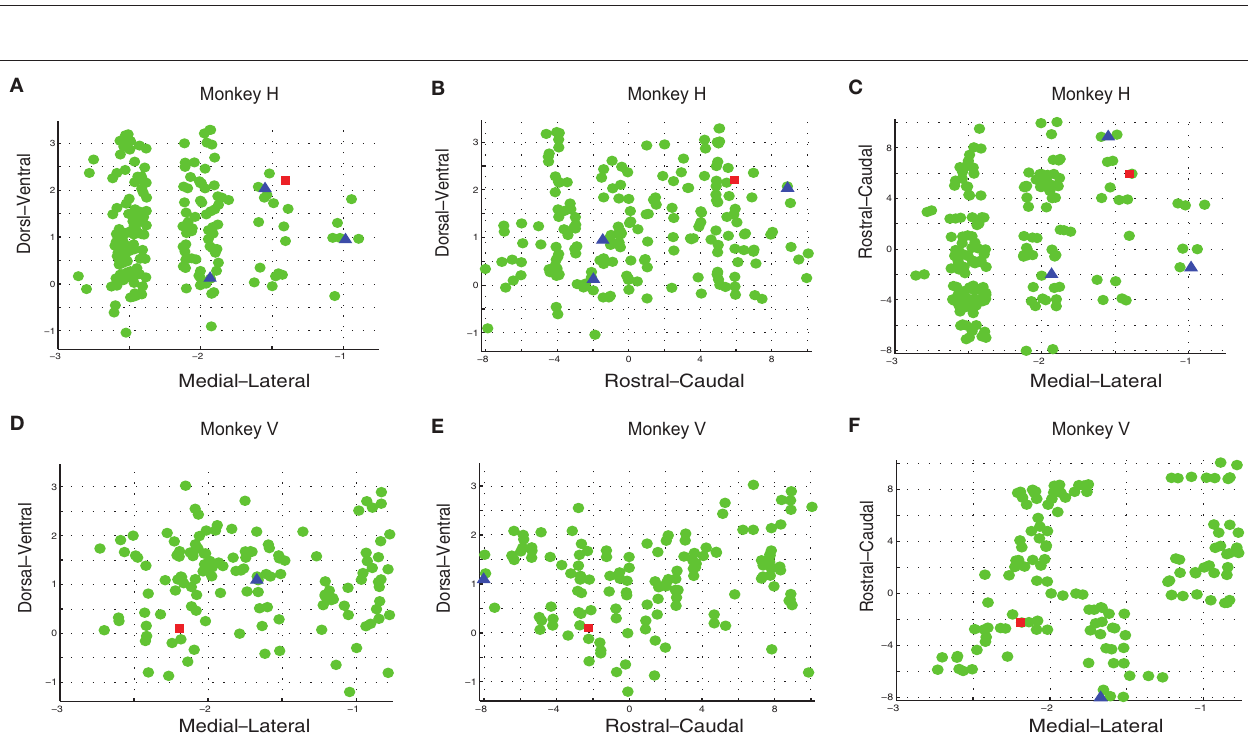
FigUre A3 | Untransformed version for the AVPSD method in Monkey V. See Figure 4 for further explanations.